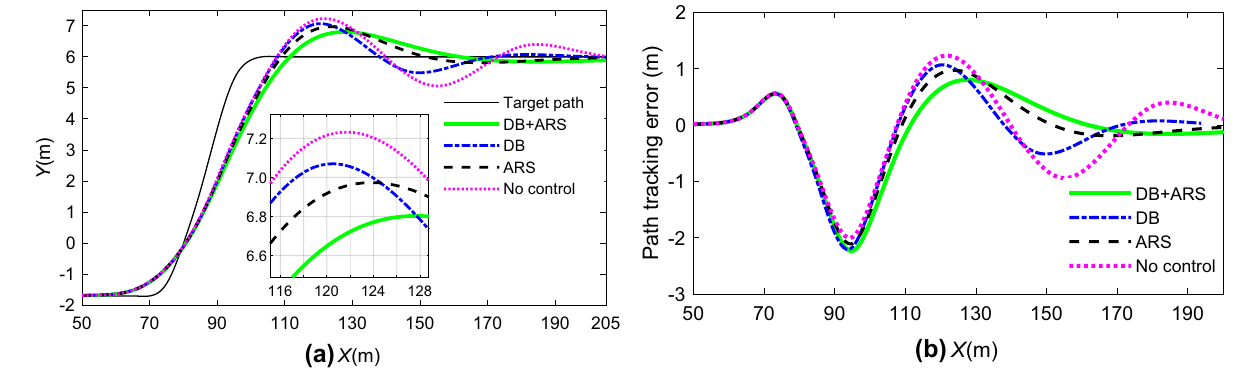
Figure 20. Vehicle tracking performance: ( a )path tracking; ( b ) path tracking